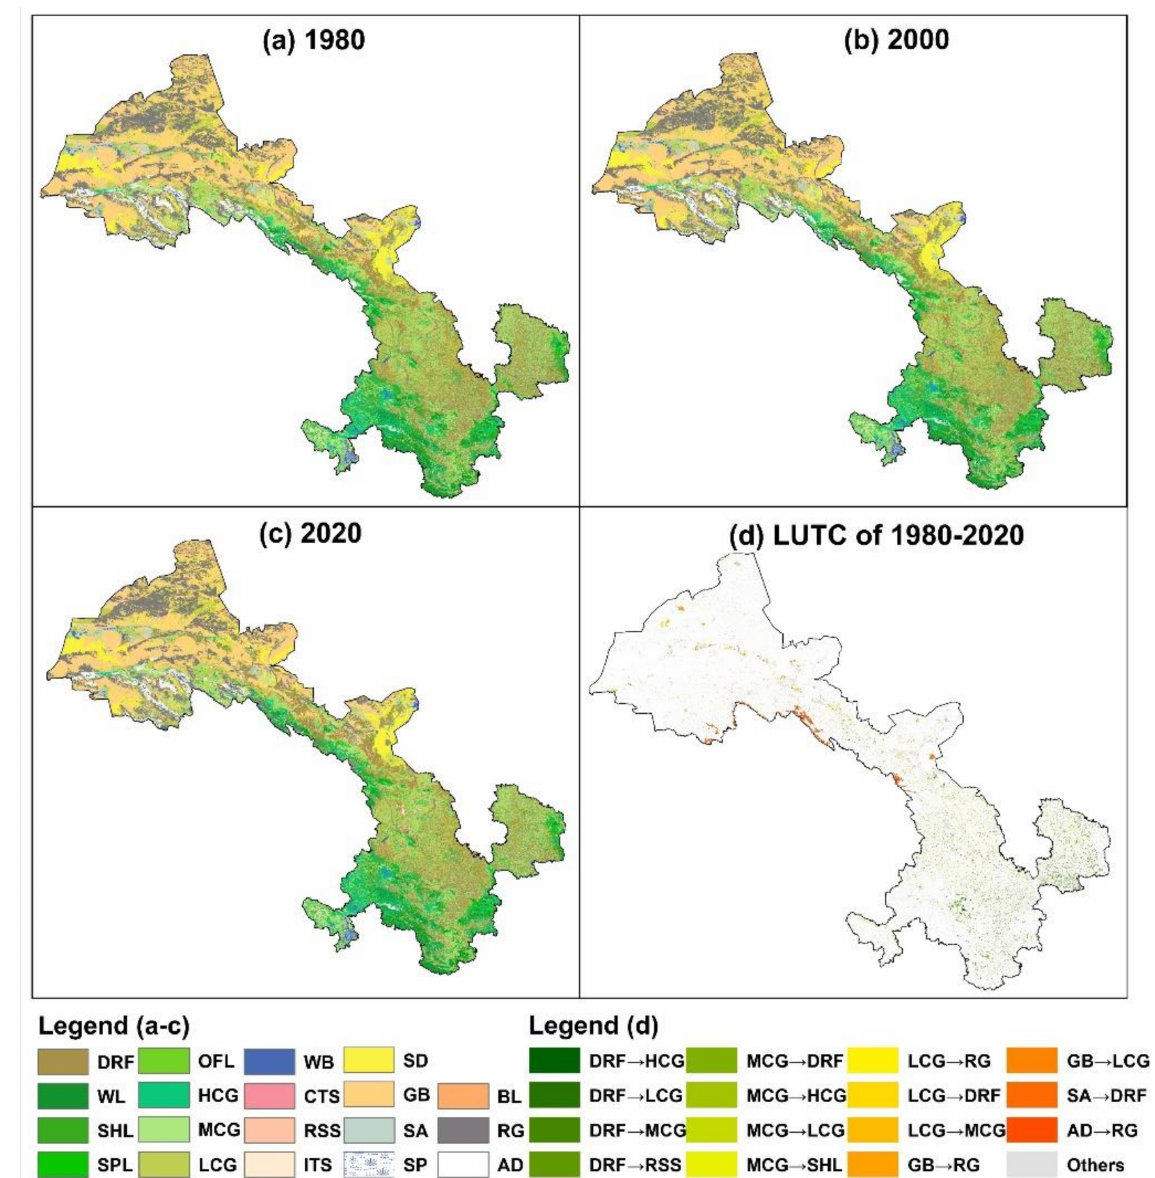
Figure 3. The spatial-distribution of LUCC ( a – c ) and LUTC ( d ) in Gansu from 1980 to 2020. DRF: dry farmland; WL: wood land; SHL: shrubbery land; SPL: sparsely forested woodland; OFL: other forest land; HCG: high coverage grassland; MCG: mid-coverage grassland; LCG: low coverage woodland; WB: river and glacier; CTS: cities and towns; RSS: rural settlements; ITS: industry and traffic land; SD: sandy land; GB: Gobi; SA: saline-alkali land; SP: swampland; BL: bare land; RG: rock and gravel; and AD: alpine